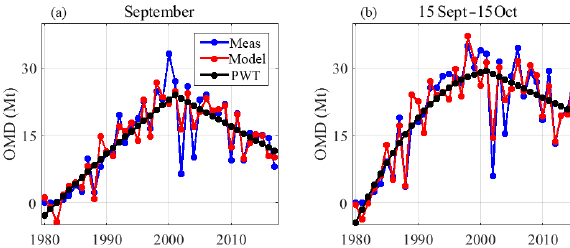
Figure 11. OMD (in Mt) computed from total columns of MSR-2 dataset lower than 220DU and south of 60 ◦ S for September (a) and 15 September–15 October (b) . Regressed values by MLR analysis using GRAD, HF and PWT are also shown as well as the fitted PWT